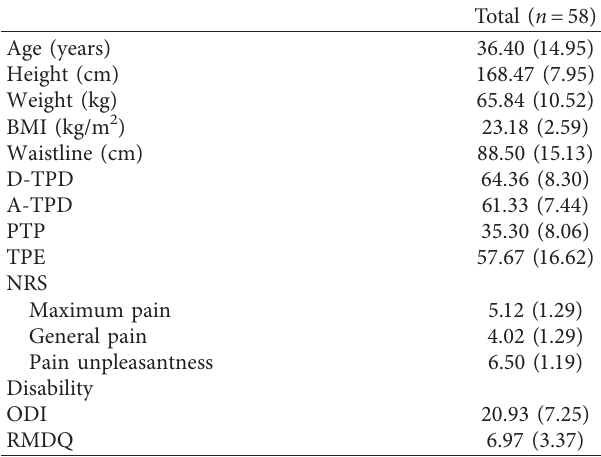
Table 1: Participant